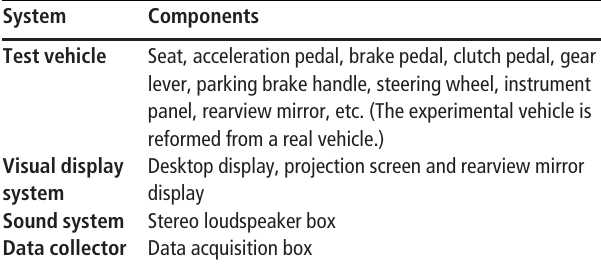
Table II Hardware & equipment of driving simulators System Components Test vehicle